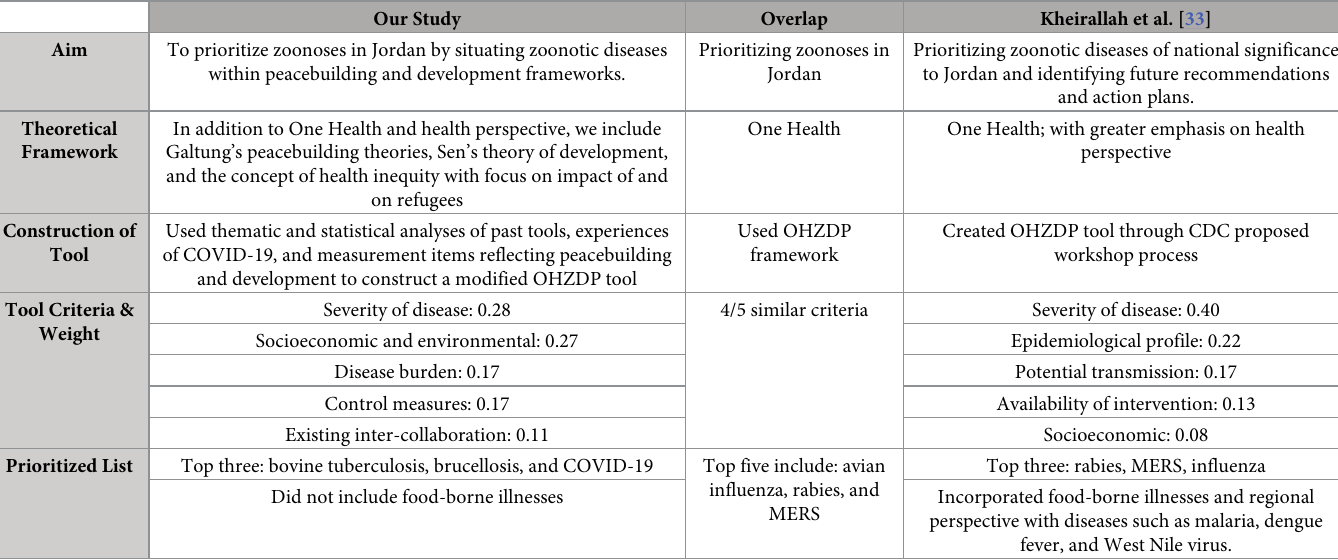
Table 7. Comparison of our research and Kheirallah et